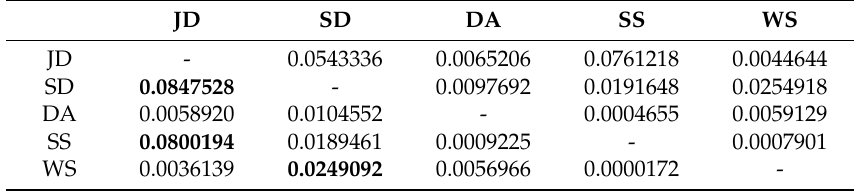
Table 2. Analysis of the iterations of the variables. Contribution to the